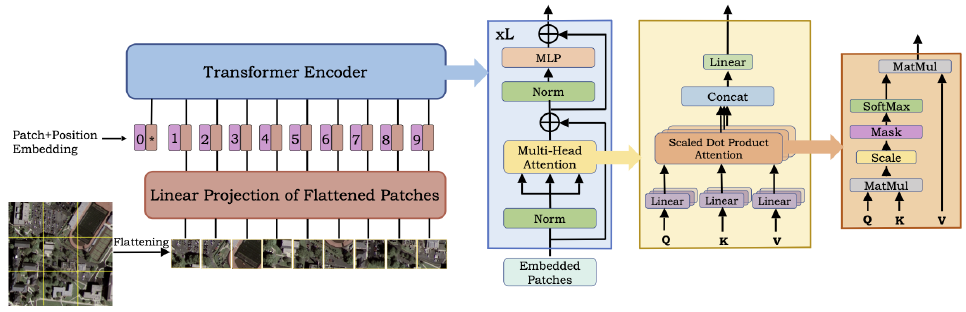
Figure 3. The vision transformer’s architecture is shown on the left and the encoder block’s spec- ifications are shown on the right. The input image is first divided into patches. These are then projected (after flattening) into a feature space, where a transformer encoder analyzes them to create the classification output. * indicates to Extra learnable [class] embedding. Adapted with permission from